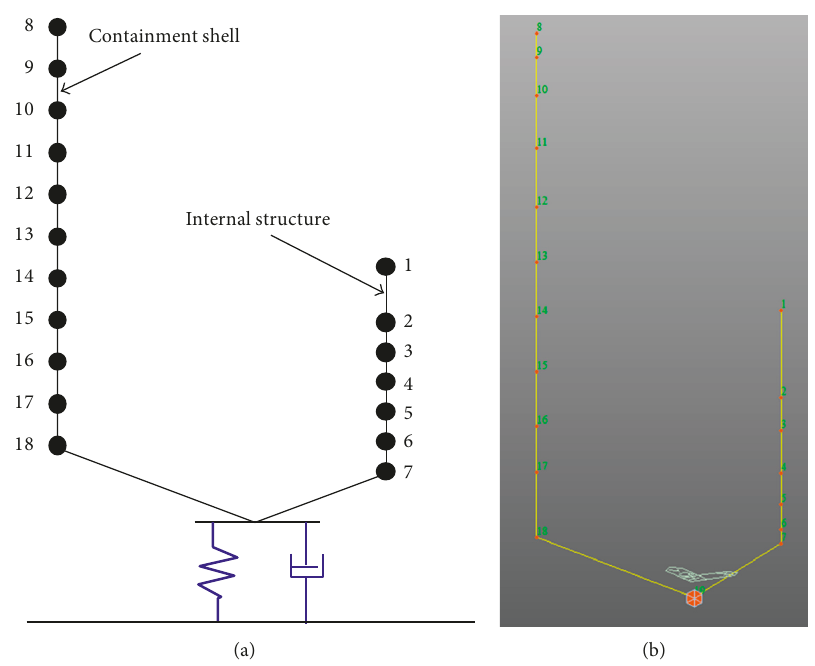
Figure 6: Lumped-mass stick model for the NPP containment building: (a) conceptual model; (b) numerical model in MIDAS